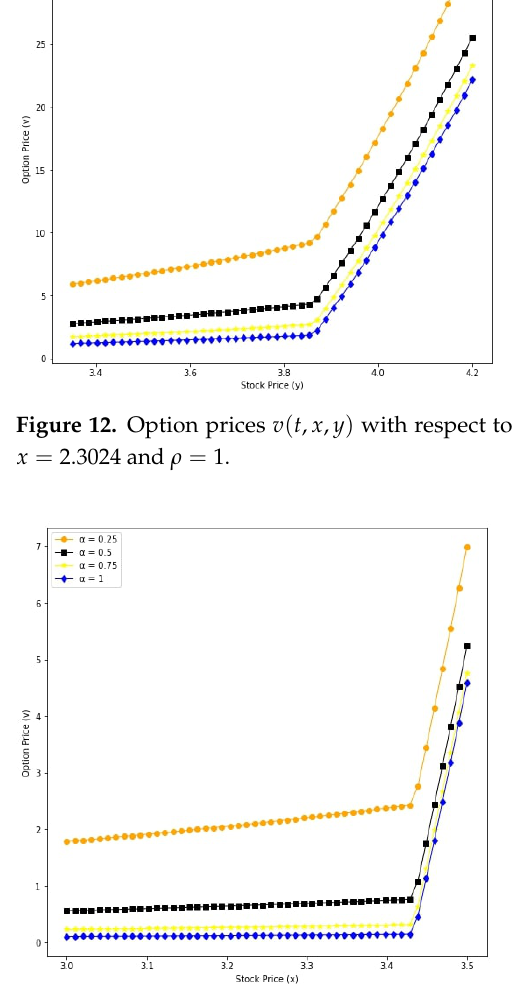
Figure 13. Option prices v ( t , x , y ) with respect to underlying asset x for different α values : v for y = 1.6093 and ρ =